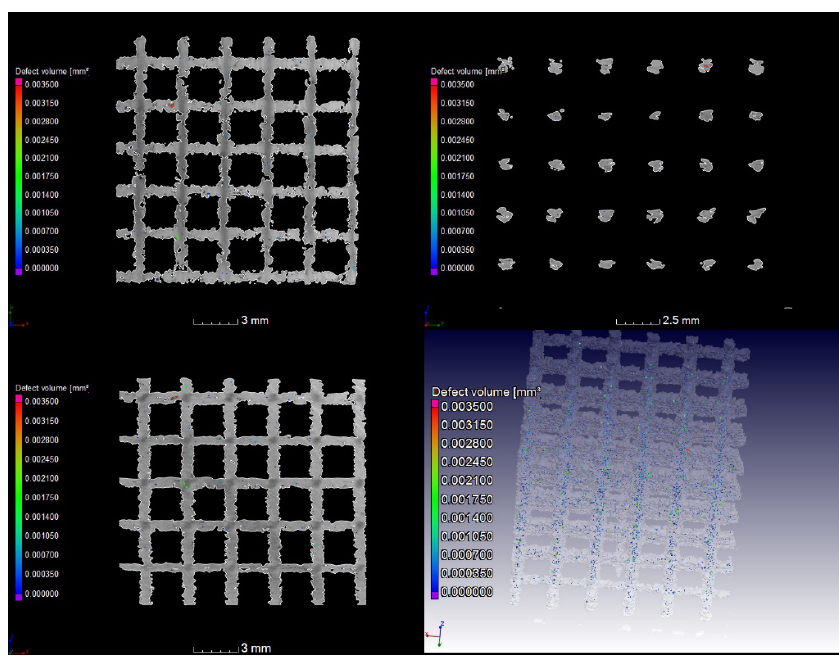
Figure 15. Internal defect volume analyzed by µ-CT (0.5 mm strut). Table 3. Quantitative assessment of internal porosity by µ-CT.